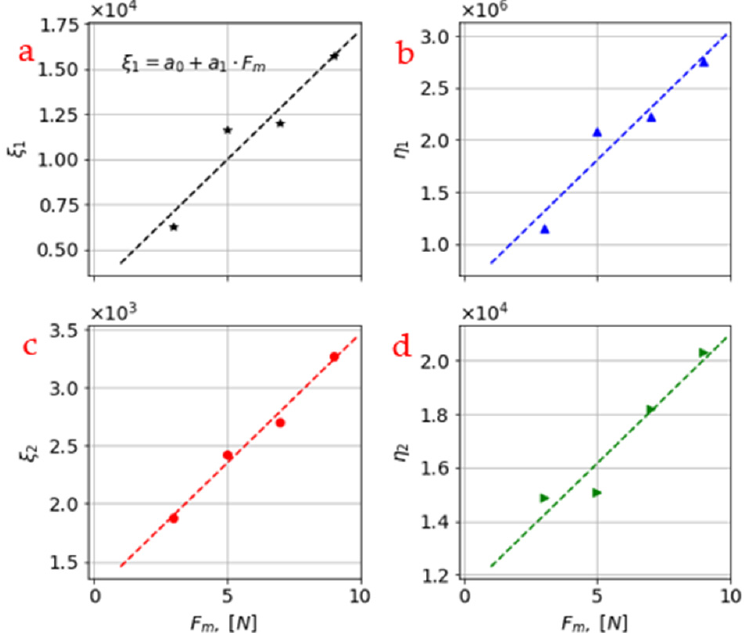
Figure 6. The individual parameters for each mechanical-loading level are plotted here to generate model parameters that are linearly dependent on the mechanical force (F m ). F m is given as 3 N, 5 N, 7 N, and 9 N. ( a ) ξ 1 . ( b ) η 1 . ( c ) ξ 2 . ( d ) η 2 . Table 4. Linear model parameters for ξ 1 , η 1 , ξ 2 and η 2 . Each model parameter is given